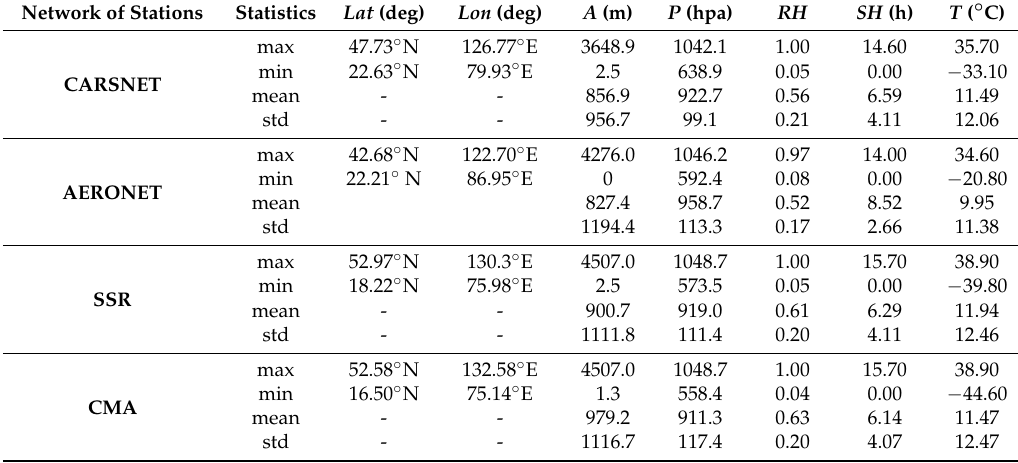
Table 1. Geographical and annual mean meteorological data at CARSNET, AERONET, SSR and CMA stations.